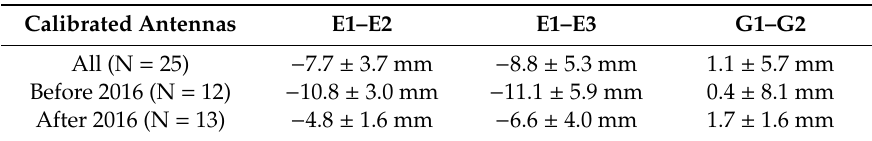
Table 4. Mean di ff erences and standard deviations in the up component between the compared solutions for the 25 analyzed stations (based on both approaches).